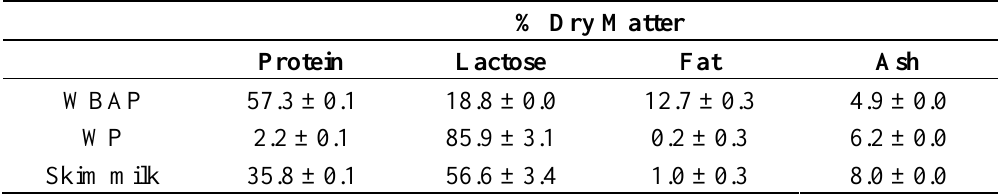
Table 3. Composition of heat-denatured whey:buttermilk aggregate (WBAP), whey permeate (WP), and powdered skim